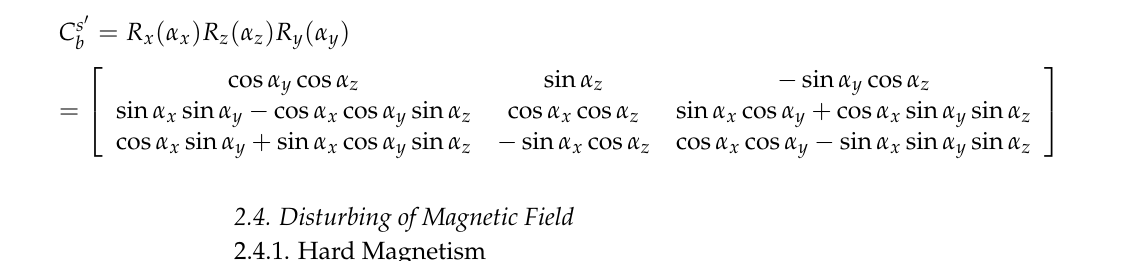
Figure 2. Schematic diagram of installation error